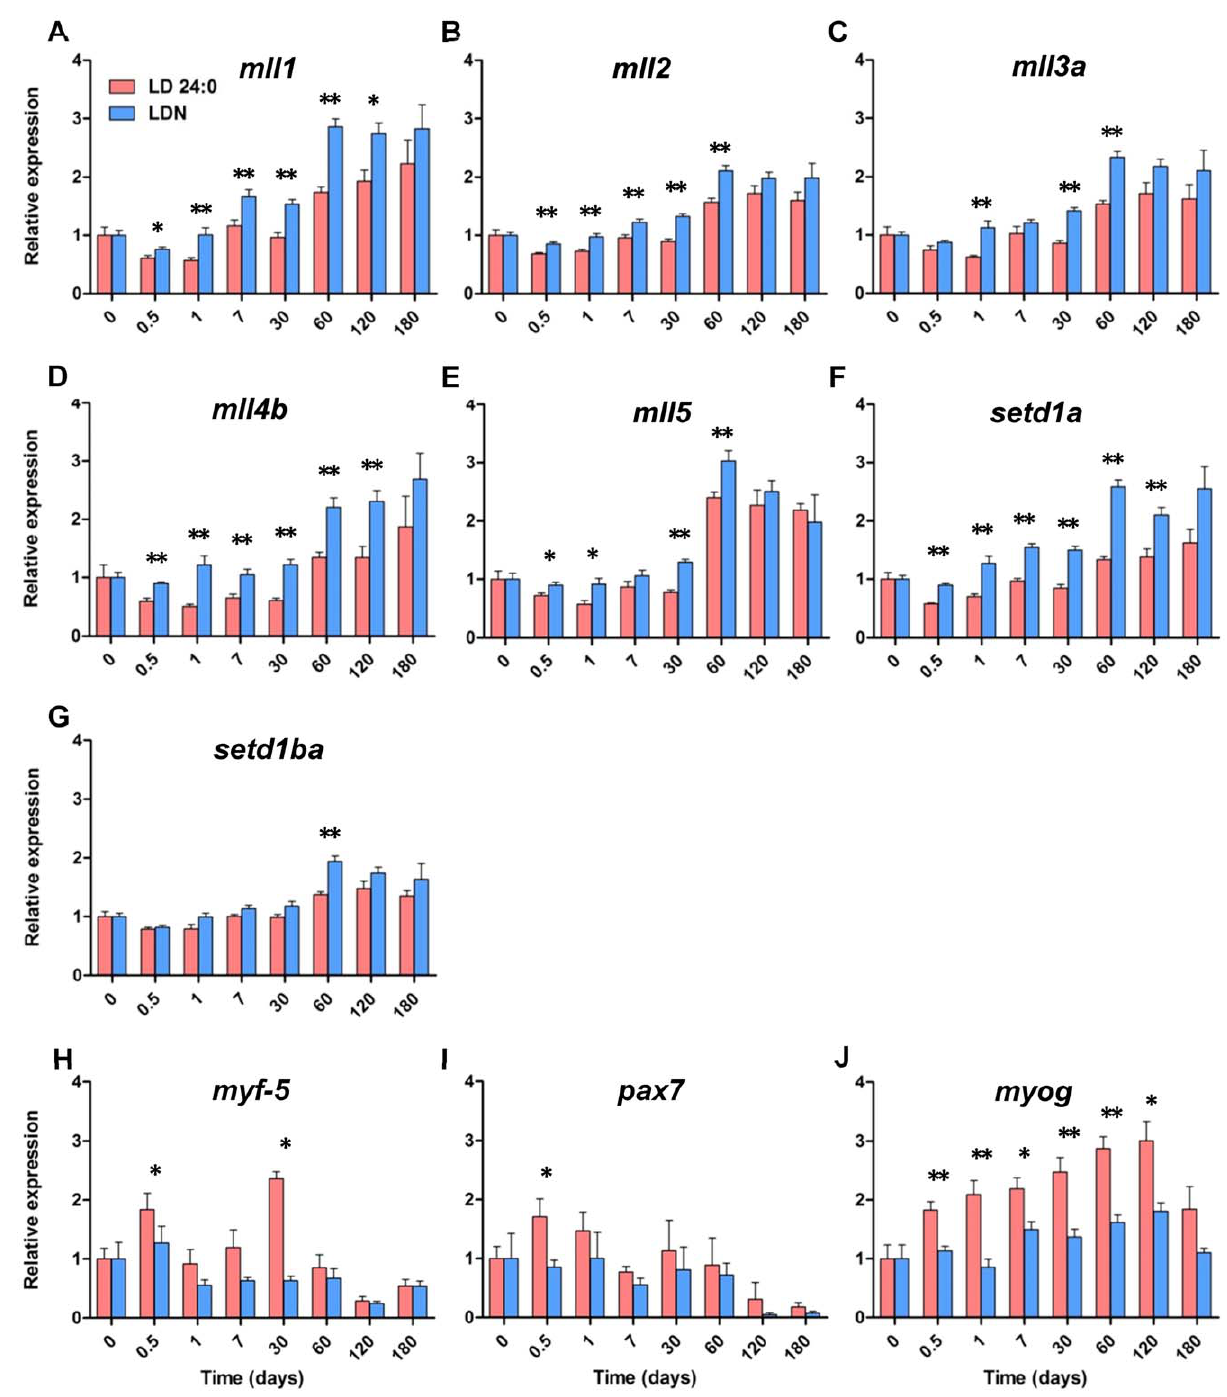
Figure 5. Quantification of mll paralogues and key myogenic genes ( myog , myf5 and pax7 ) in fast muscle of Atlantic cod juveniles reared under continuous light (red bars, LD 24:0) or natural photoperiod conditions (blue bars, LDN) for 6 months. In general, mll genes were differentially expressed between the two light groups and there was a decrease in mll transcript levels with continuous illumination as early as 12 hours, compared to the natural photoperiod group. Myog transcript levels were consistently higher in the constant light group compared to natural photoperiod. Asterisks * and ** indicate significant differences at p , 0.05 and p , 0.01, respectively (n=6). doi:10.1371/journal.pone.0036908.g005 proteins are involved in collagen cross-linking and, therefore, play and these cells have limited ability to differentiate [21]. It seems an important role in the structural integrity of muscle fibres [38]. that mll5 controls the inappropriate expression of proliferation In mll5 -knockdown mice myoblast cell lines, expression of key genes and maintains expression competence of key genes associated with myogenic differentiation in quiescent myoblasts. players in myogenesis such as Pax7, Myf5 and Myog is impaired